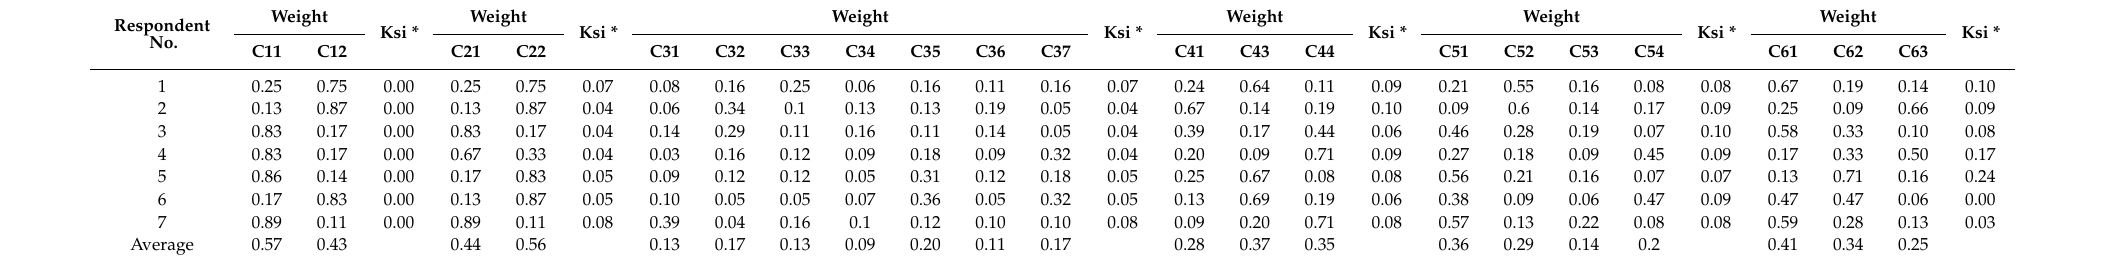
Table 14. Weight and consistency ratio of criteria.